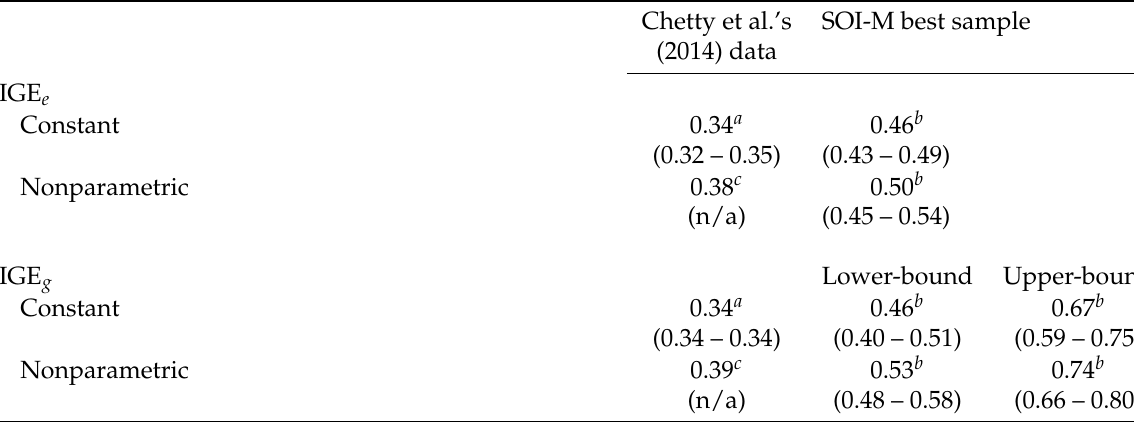
Table 3: Baseline IGE